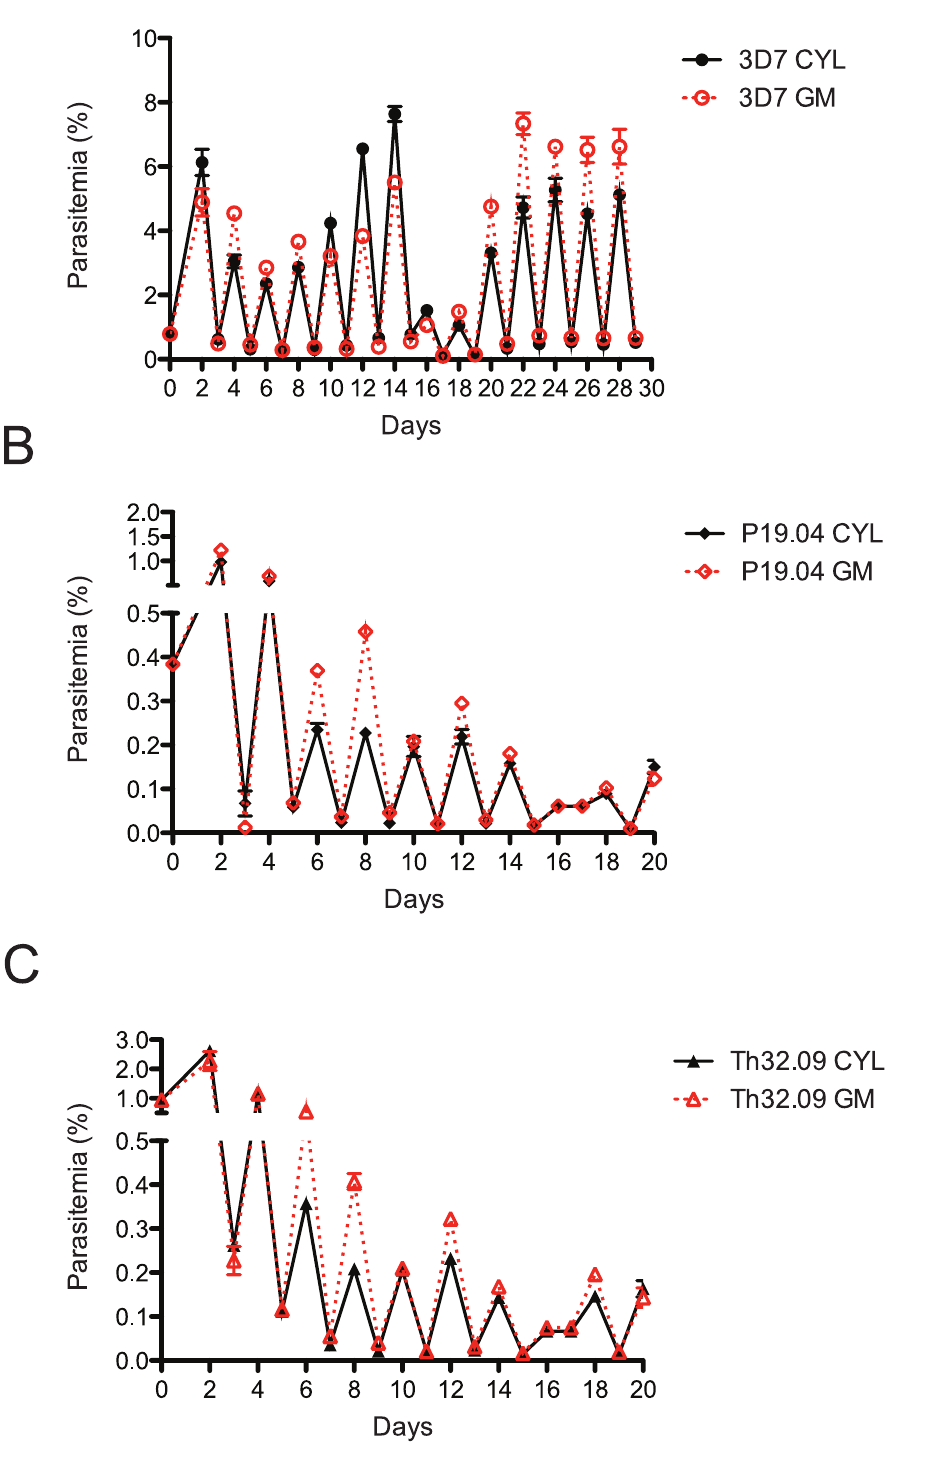
Figure 4. Semi-quantitative comparisons of long-term routine culture. A. Laboratory adapted (decades) isolate (3D7) routine growth comparisons. Cultures were split 1:10 every cycle. B & C. Short term adapted (months) Senegalese isolates routine growth comparisons. Cultures were split 1:10 every cycle, or media change only as appropriate, as indicated by action on odd days. Results from individual experiments are shown, conducted in triplicate, with error bars representing standard error.